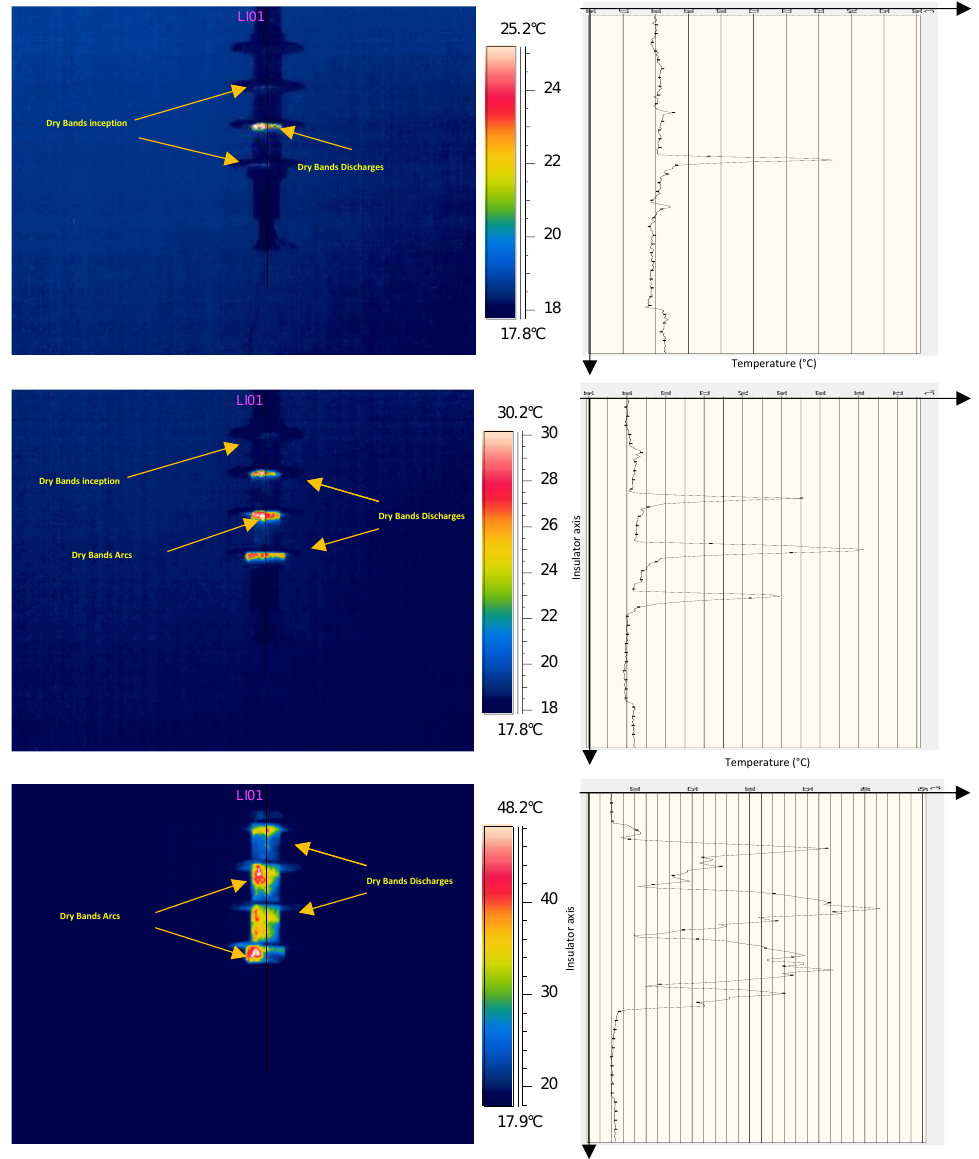
Figure 6. Infrared recording and thermal activity during the FOV test with ESDD 1 = 0.12 mg/cm 2 and NSDD 1 = 0.11 mg/cm 2 .